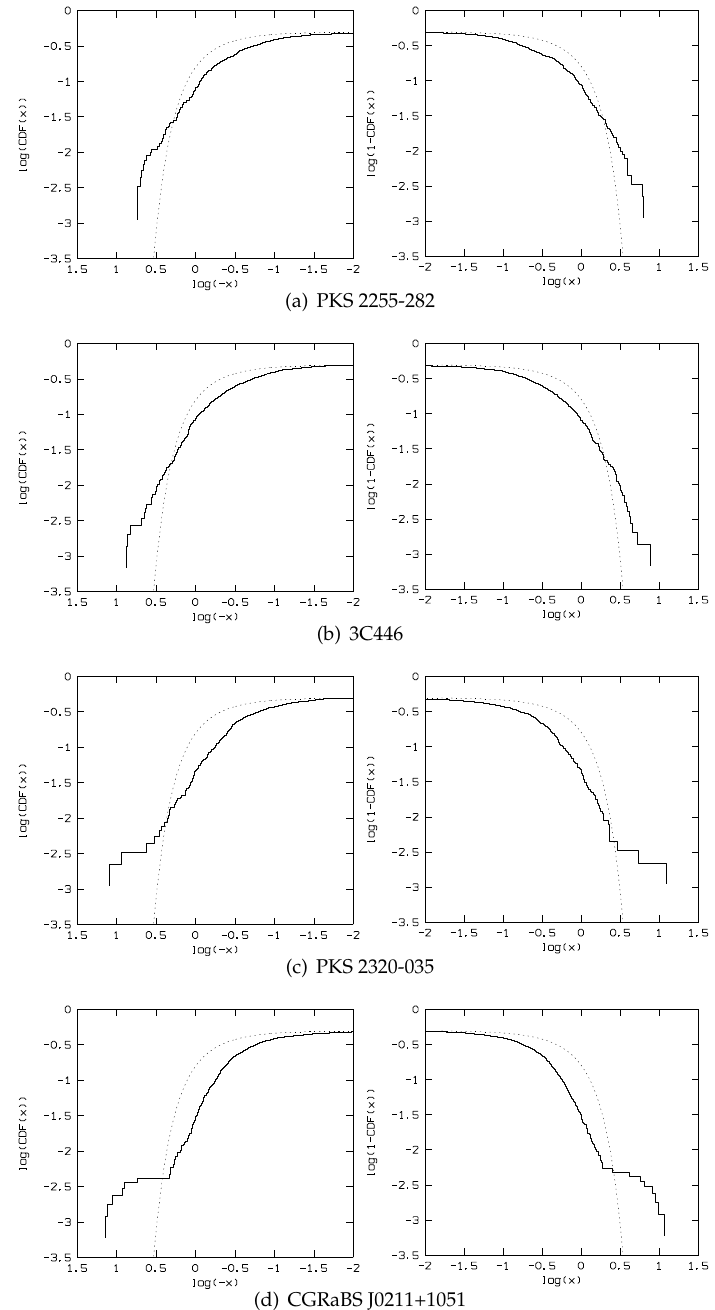
to Gaussian noise.